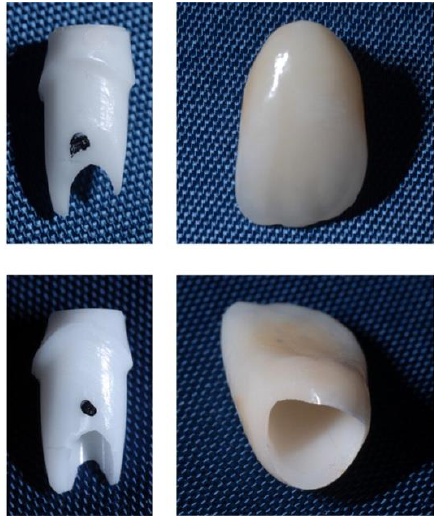
Figure 7. Details of the zirconia abutments and crowns.